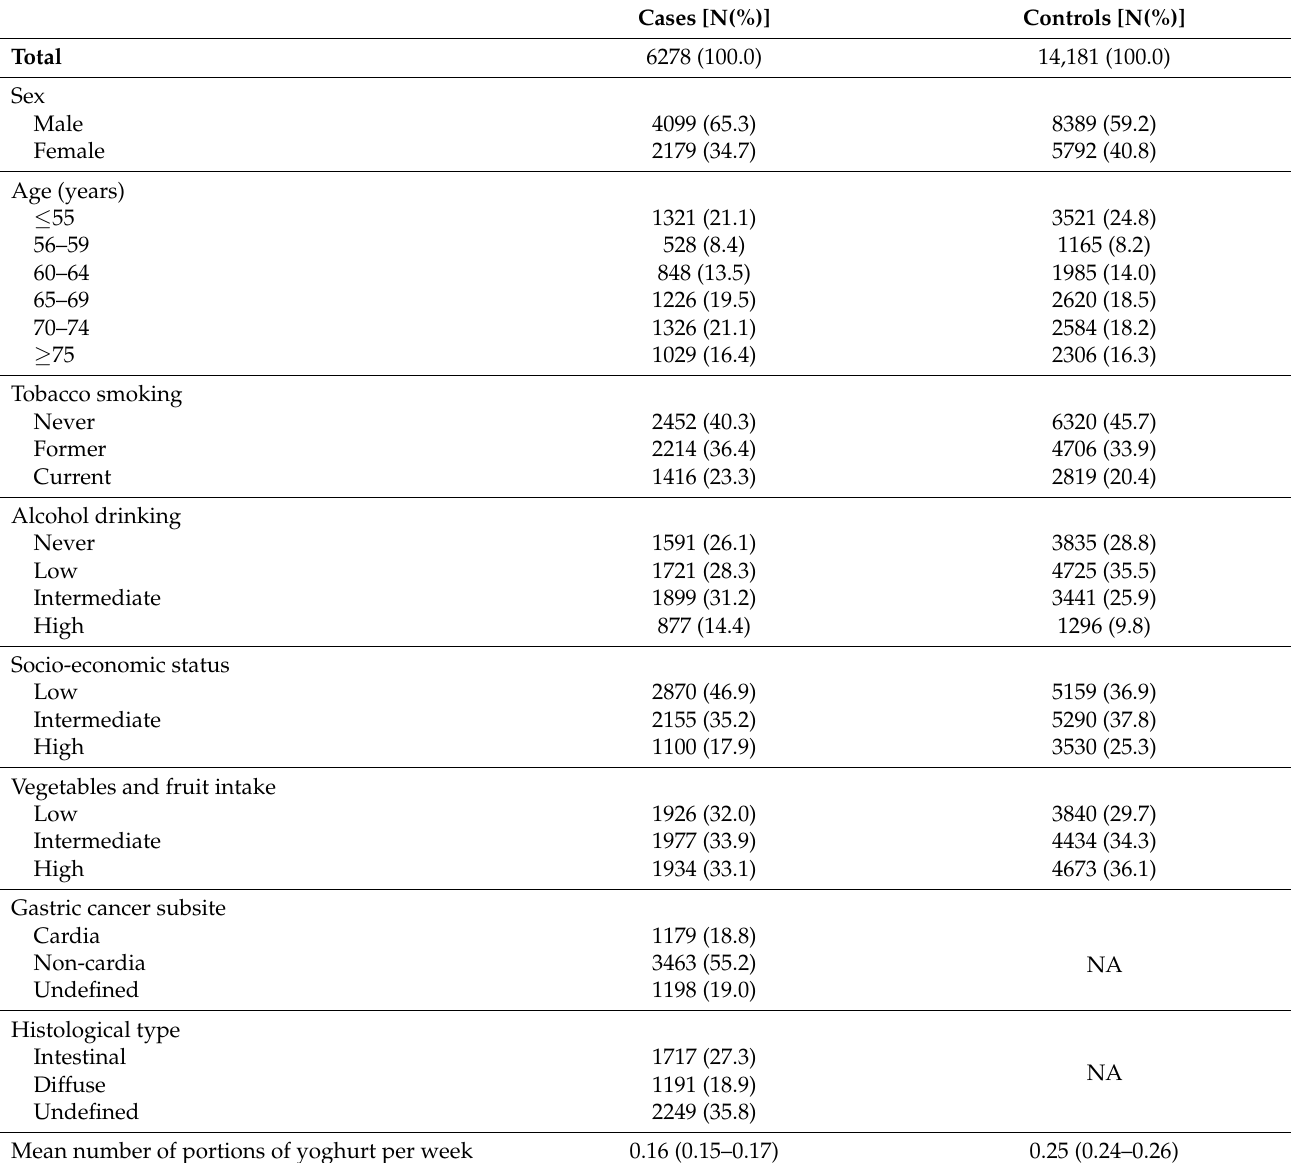
Table 1. Distribution of cases of gastric cancer and controls according to sex, age and selected covariates. Cases